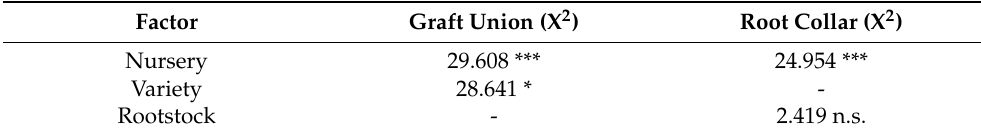
Table 6. Contribution of each factor to the presence of GTD-related fungal isolates in each tissue type (graft union and root collar). ChiSq (X 2 ) values are reported. Annotation next to the